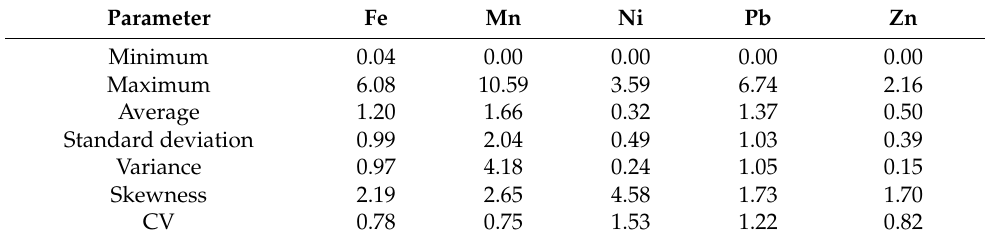
Table 1. Descriptive statistics of soil absorbable heavy metals in the study area (mg/kg − 1 ).